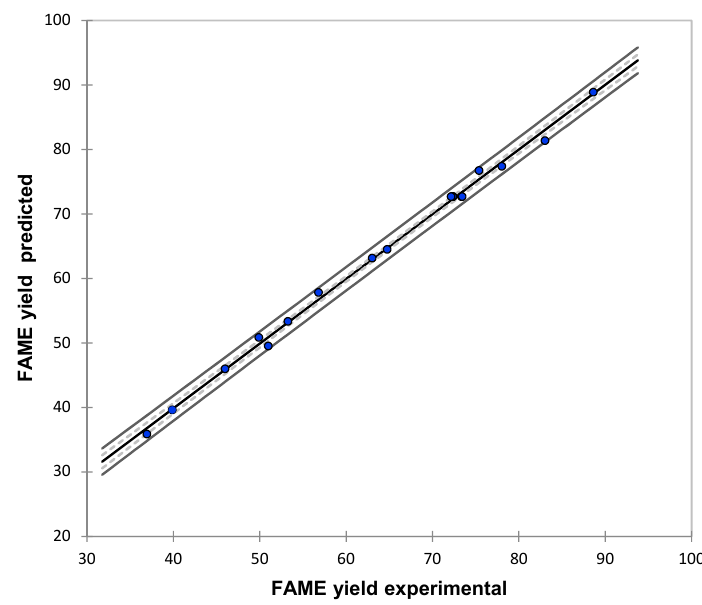
Figure 3. Scatter diagram of experimental FAME yield and predicted FAME yield.